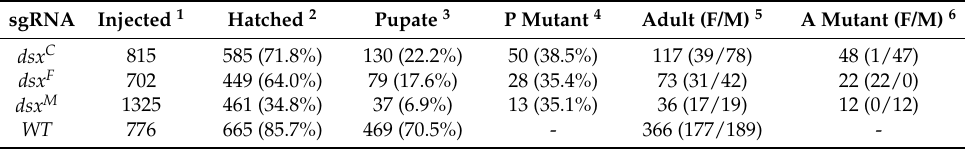
Table 1. Mutagenesis of Sfdsx induced by CRISPR/Cas9